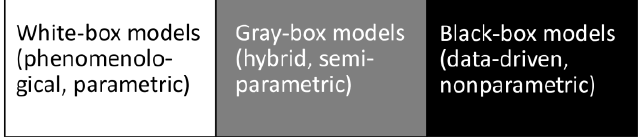
Figure 1. Three conceptual approaches to chemical engineering modeling.